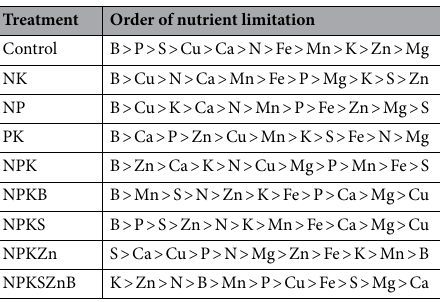
Table 6. Order of nutrient limitation for the nutrient